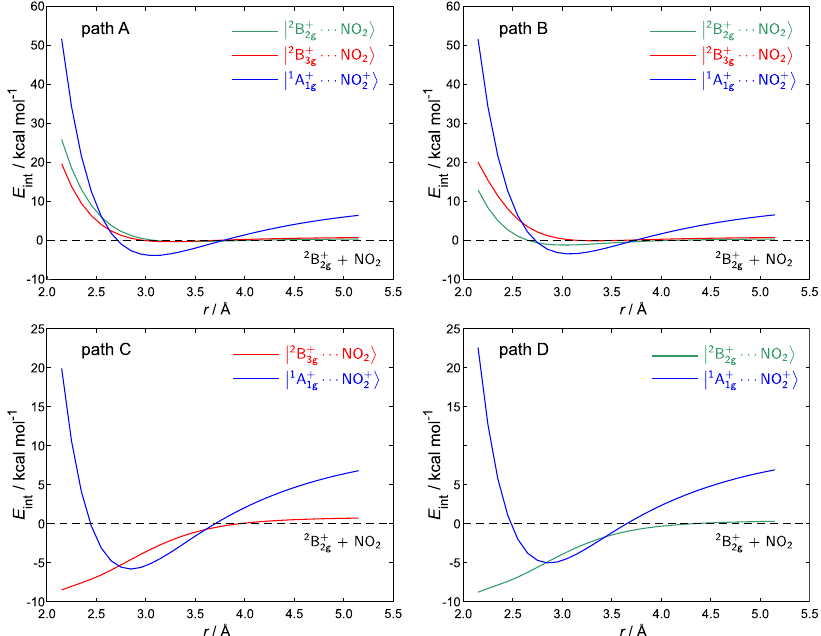
Figure 2. Predicted interaction energy of benzene/benzene + with NO + function of the distance of the interacting units, oriented as in the paths A, B, C, and D of Figure